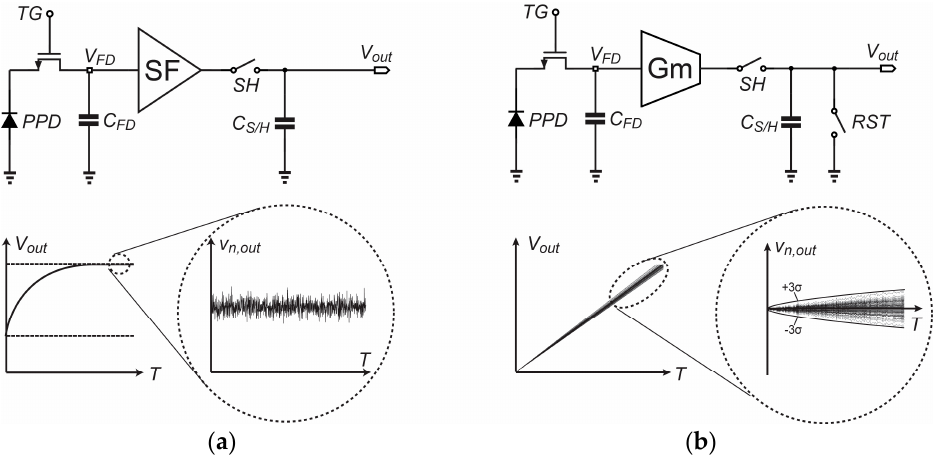
Figure 5. ( a ) Steady-state noise waveform for source followers (SF)-based pixel ( b ) Non-steady-state noise waveform for Gm-cell-based pixel.